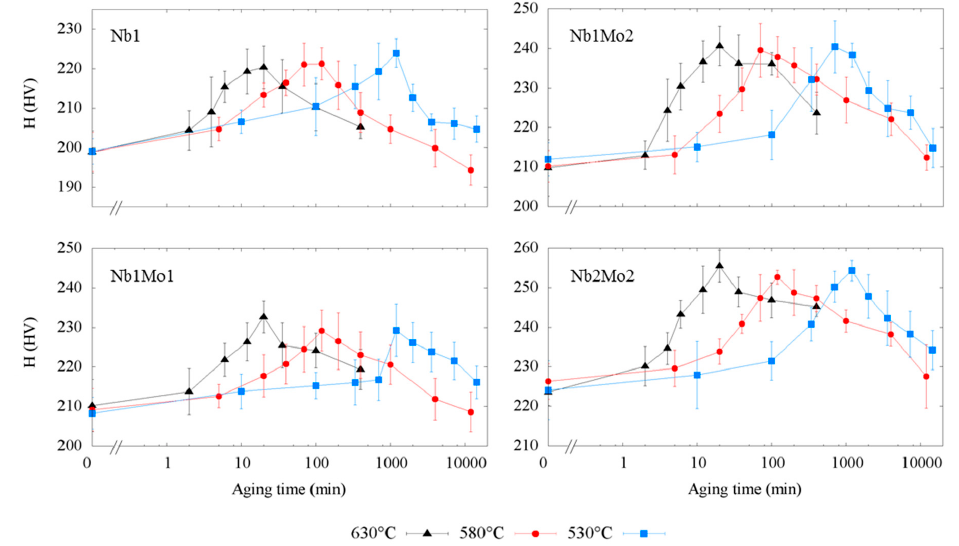
Figure 3. Hardness, H , evolution during aging treatments of the as-quenched specimens for the four investigated steels: Nb1, Nb1Mo1, Nb1Mo2, Nb2Mo2. The error bars indicate the standard deviation from the ten hardness